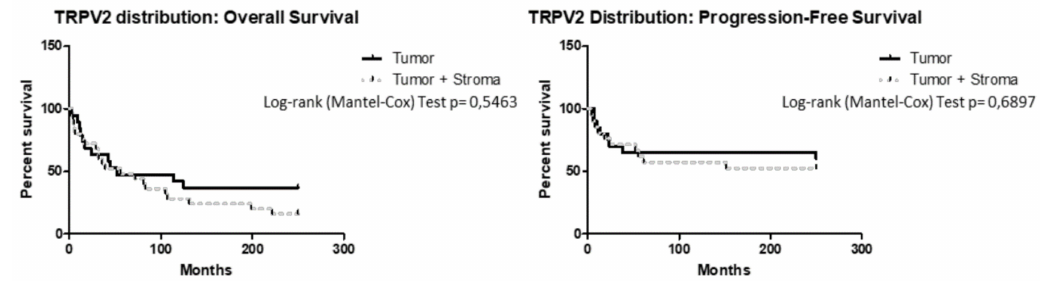
Figure 4. Survival of EC patients according to TRPV2 distribution. Kaplan–Meier survival curves showing OS and PFS of EC patients, according to TRPV2 distribution inside tumoral mass. The log-rank test with corresponding p values applies to the TRPV2—tumor and TRPV2—tumor + stroma.